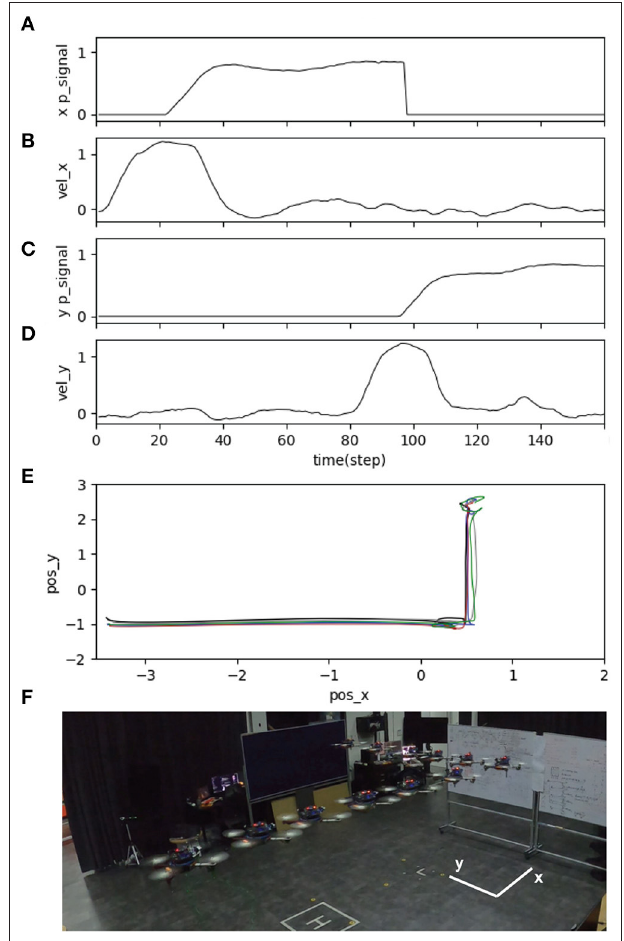
FIGURE 15 | Real-time data of speed adaptation in the forward and sideward directions of the UAV, when flying the UAV in the real environment at a maximum speed of 1.0 m/s and a predictive weight of 1.07. (A) Predictive signal from the distance sensor for detecting an obstacle in the forward direction. (B) Actual speed in the forward direction. (C) Predictive signal from the distance sensor for detecting an obstacle in the sideward direction. (D) Actual speed in the sideward direction. (E) Position of the UAV plotted on the x-y axis to show its overall trajectory five times repeatedly. (F) Automatic flying behavior of the UAV (see from the left to right). A video of this experiment can be viewed on www.manoonpong.com/DSA/video6.mp4.